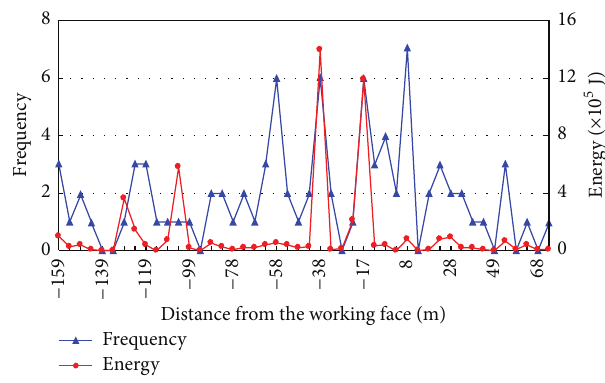
Figure 10: Statistics of microseismic events at an interval of 5 m on the fixed driving face.